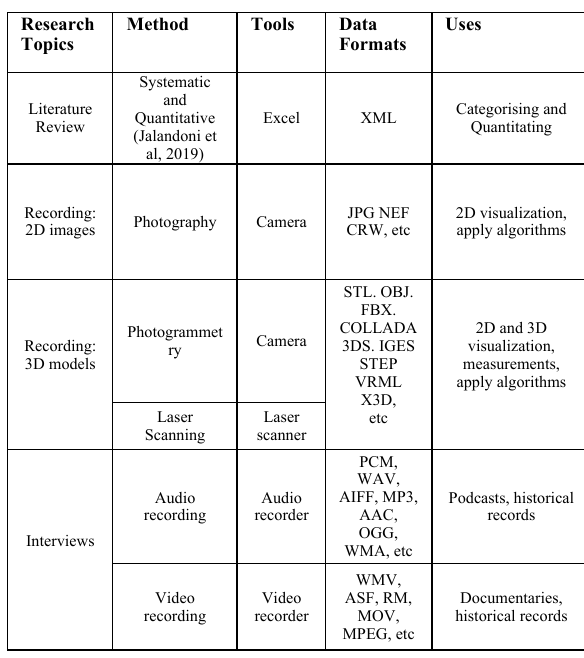
Table 1. Examples for rock art data gathering methods